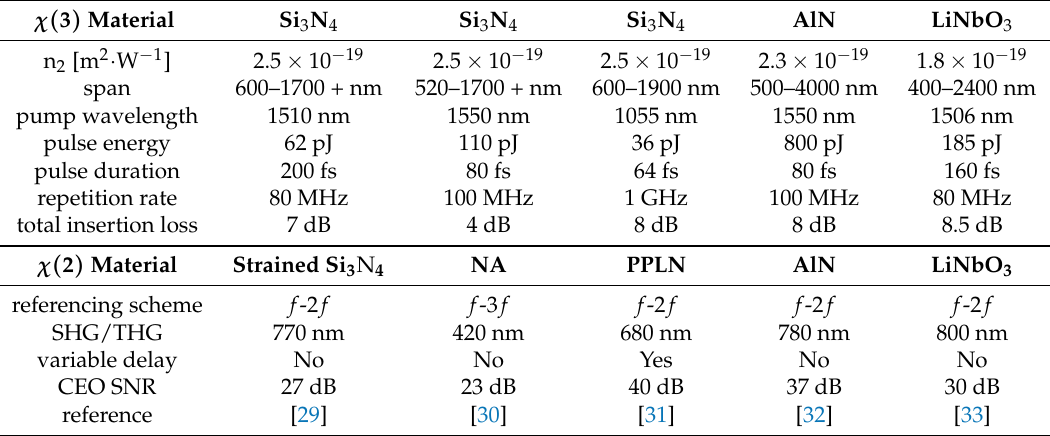
Table 1. On-chip CEO detection experiments. Abbreviations: SHG—second harmonic generation, THG—third harmonic generation, CEO SNR—carrier envelope offset signal to noise